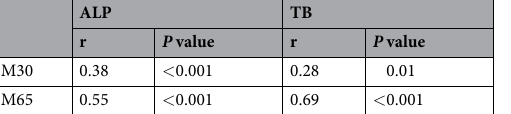
Table 2. Association between cell death biomarkers and ALP or TB. ALP, alkaline phosphatase; TB, total bilirubin.